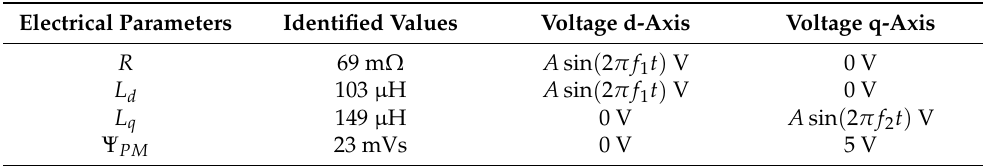
Table 2. Identified electrical parameters using the RLS and the DFC estimated electrical rotor position and excitation inputs used for the identification